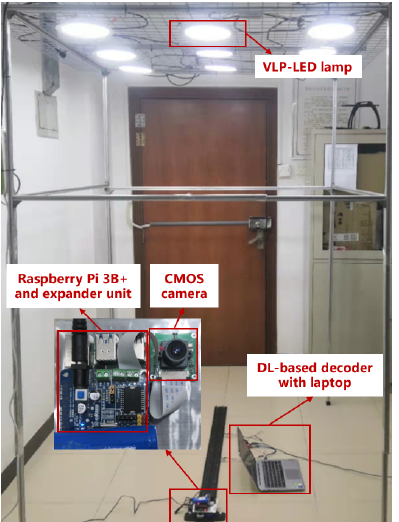
Figure 7. Experimental environment